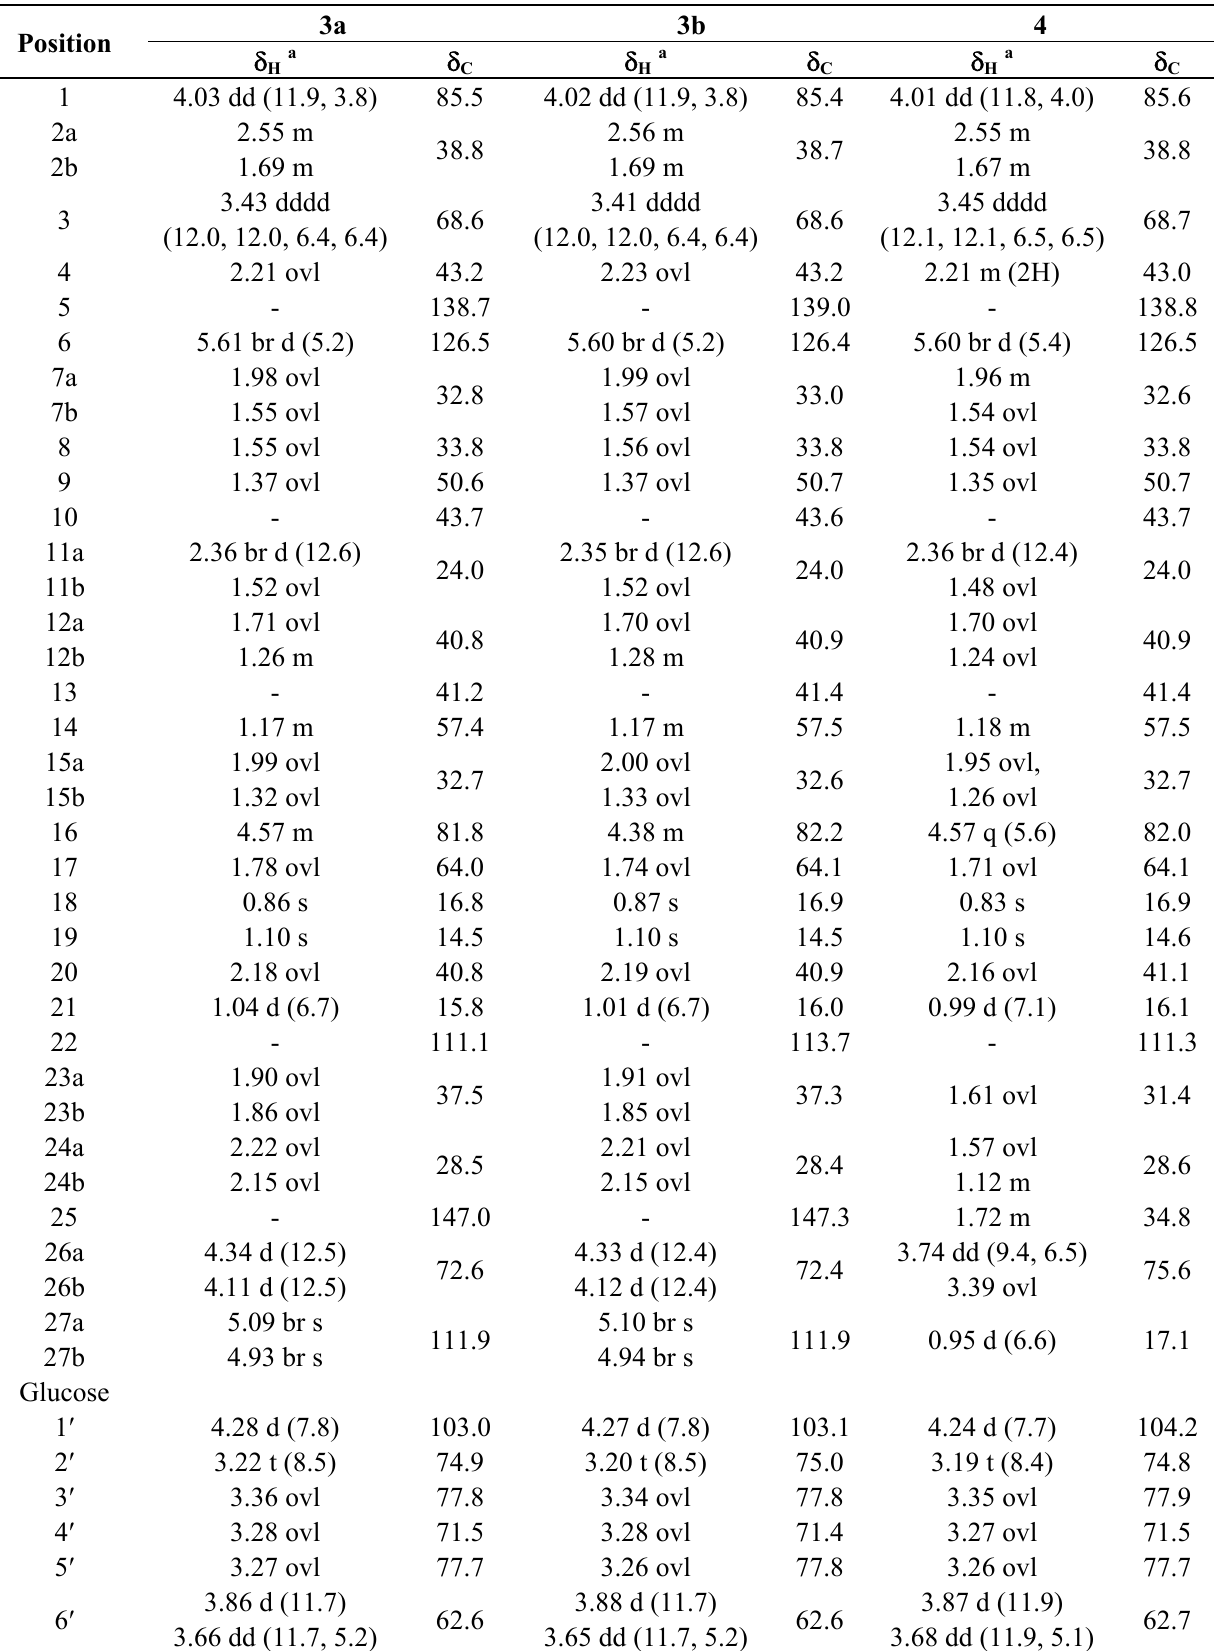
OD, 500 and 125 MHz) data of compounds 3a , 3b and 4 3